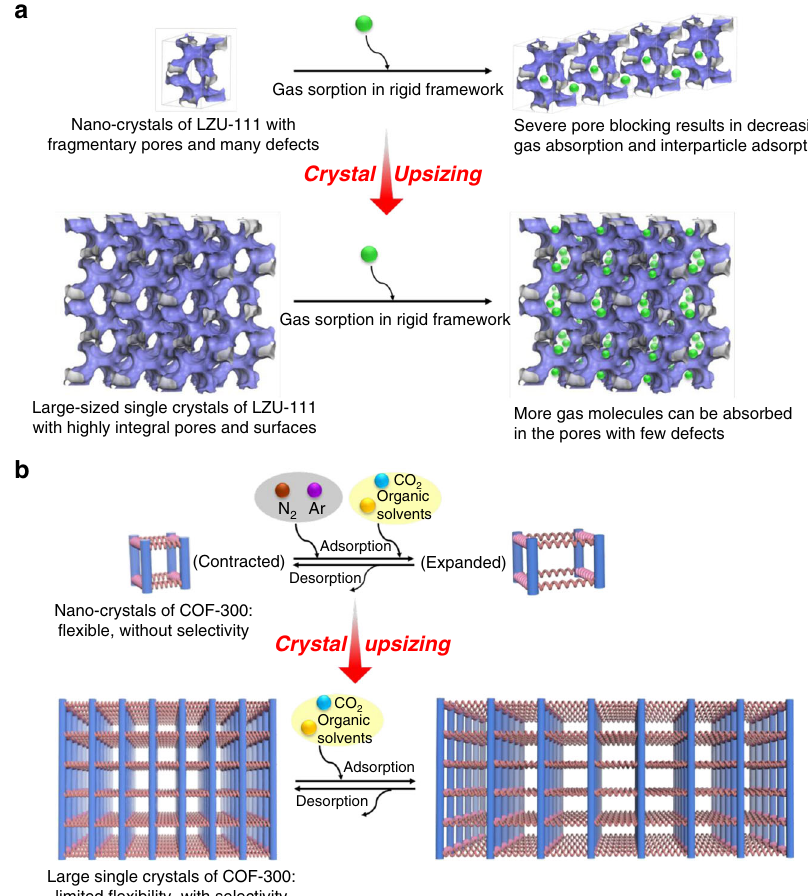
Fig. 5 Diverse crystal size effects of LZU-111 and COF-300. a Small crystals of LZU-111 (represented by a 1 × 1 × 1 unit cell) with fragmentary pores and many defects, which has a small gas sorption quantity with some interparticle adsorption. After crystal upsizing, large single crystals of LZU-111 (represented by 3 × 3 × 3 unit cells) adsorb more gas molecules in their highly integral channels. b As a springs framework model, small crystals of COF- 300 with few repeating units are more fl exible, which can absorb different gases without selectivity by changing itself from contracted structure to expanded structure easily. With crystal upsizing, large single crystals of COF-300 with more repeating units are more rigid, selectively adsorbing only CO 2 and organic solvents molecules which can interact with the framework to expand